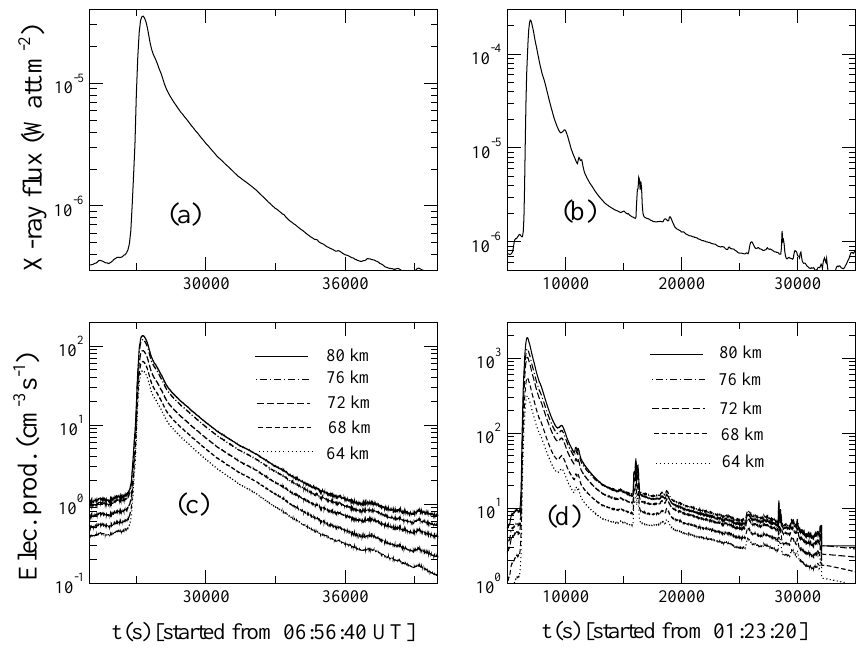
Fig. 5. Light curves of the flares from GOES satellite of an (a) M-class and (b) X-class flare. The time variation of the electron production rates at different heights as obtained from GEANT4 simulation for these flare respectively are shown in (c) and (d).